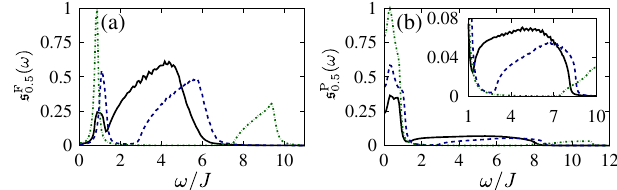
FIG. 23. RPA spectrum collected by a lens for different values of the on-site interaction strength U at T ¼ 0 . Here, the number of sites is 40 × 40 . The lattice height is s ¼ 25 and κ ¼ 1 . 5 . Light is collected with a lens of NA ¼ 0 . 5 pointing in (a) the forward direction [Fig. 16(b)] and (b) the perpendicular direction [Fig. 16(c)]. From left to right, the black (solid) line is m 0 . 19 ( U ≈ 2 . 6 J ), the blue (dashed) line is m ( U ≈ 4 . 0 J ), and the green (dot-dashed) line is m ( U ≈ 8 . 3 J ). The inset in (b) shows the renormalized single- particle excitations starting at ω ≈ U=J . All the curves have been normalized to the maximum of the m